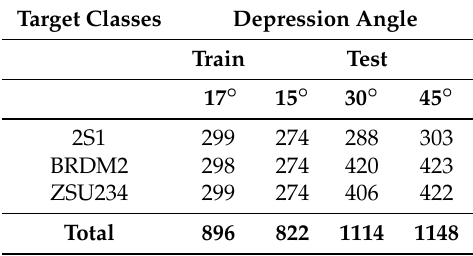
Table 5. Number of SAR images in MSTAR database under depression variation: